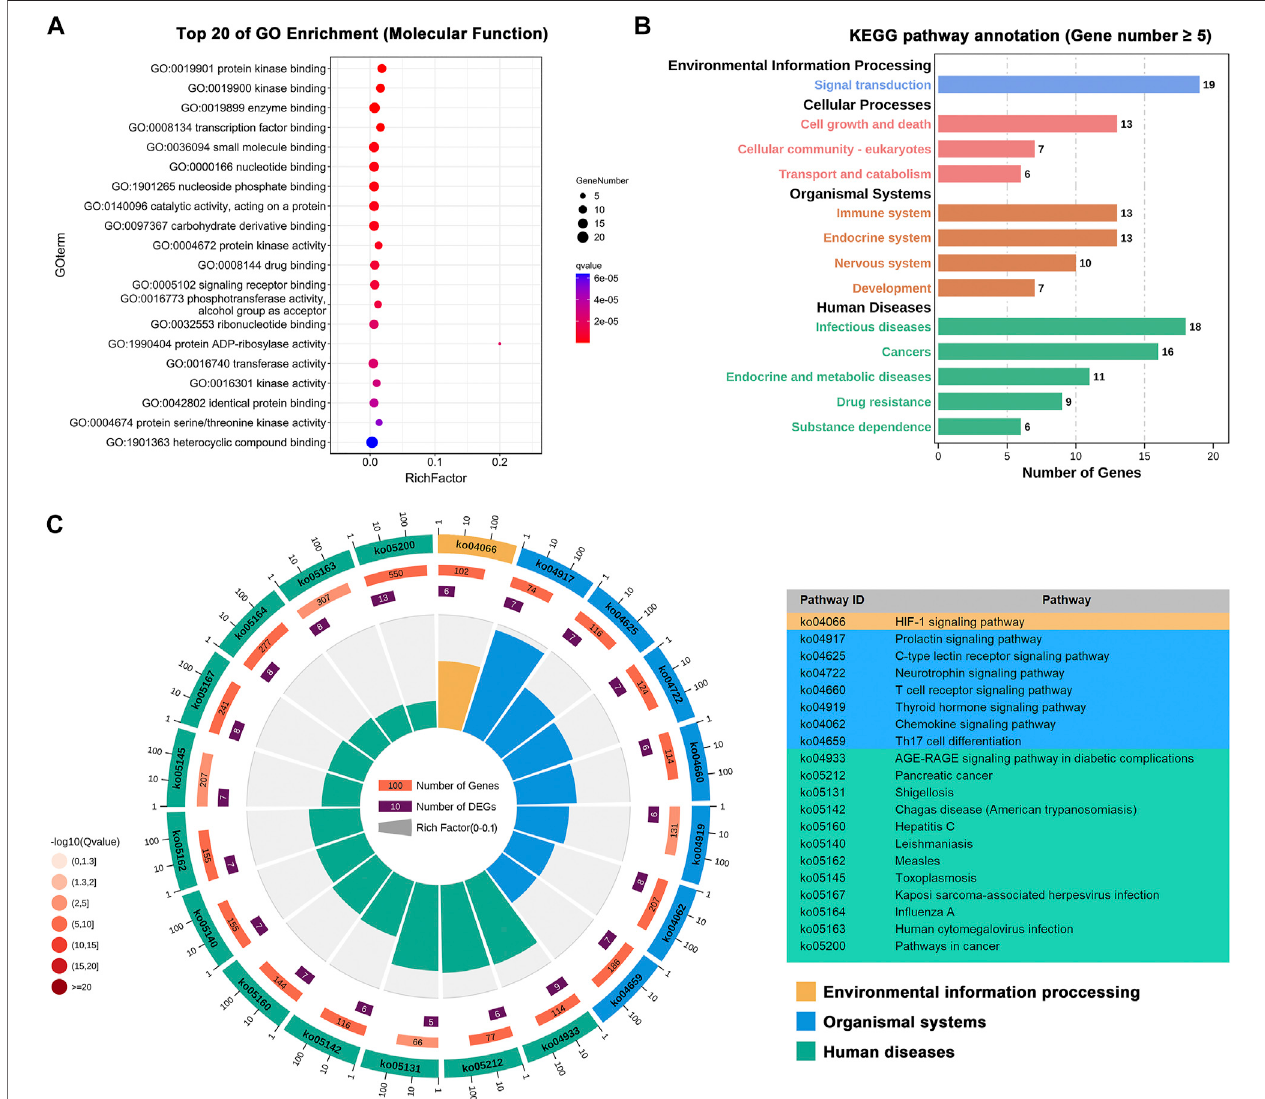
FIGURE 7 | Exploration of the molecular mechanisms of Isatis tinctoria L. (BLG) against in fl uenza A virus (IAV) through gene enrichment analysis. Gene Ontology (GO) and Kyoto Encyclopedia of Genes and Genomes (KEGG) annotations were performed on the 27 in fl uenza virus host genes that may be regulated by the 23 predictedanti-IAVcompoundsinBLGidenti fi edbynetworkanalysis. (A) Top20molecularfunctiontermsinGOenrichmentwiththelowest q values. (B) KEGGpathway annotation. Different KEGG classes are displayed in various colors . (C) Top 20 terms in KEGG enrichment with the lowest q values.